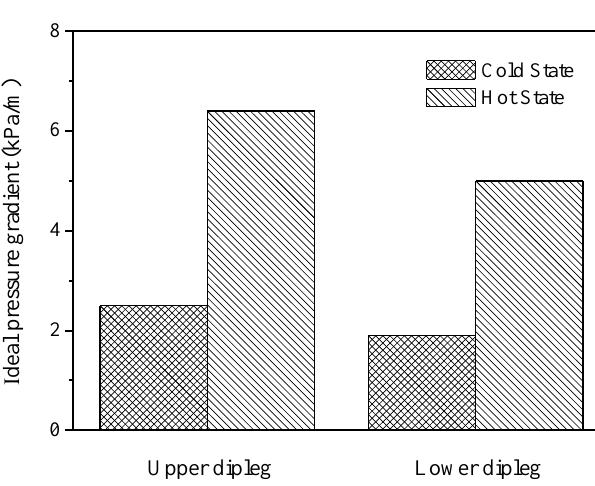
Figure 8. Comparison of the ideal pressure gradients between the hot and cold states.